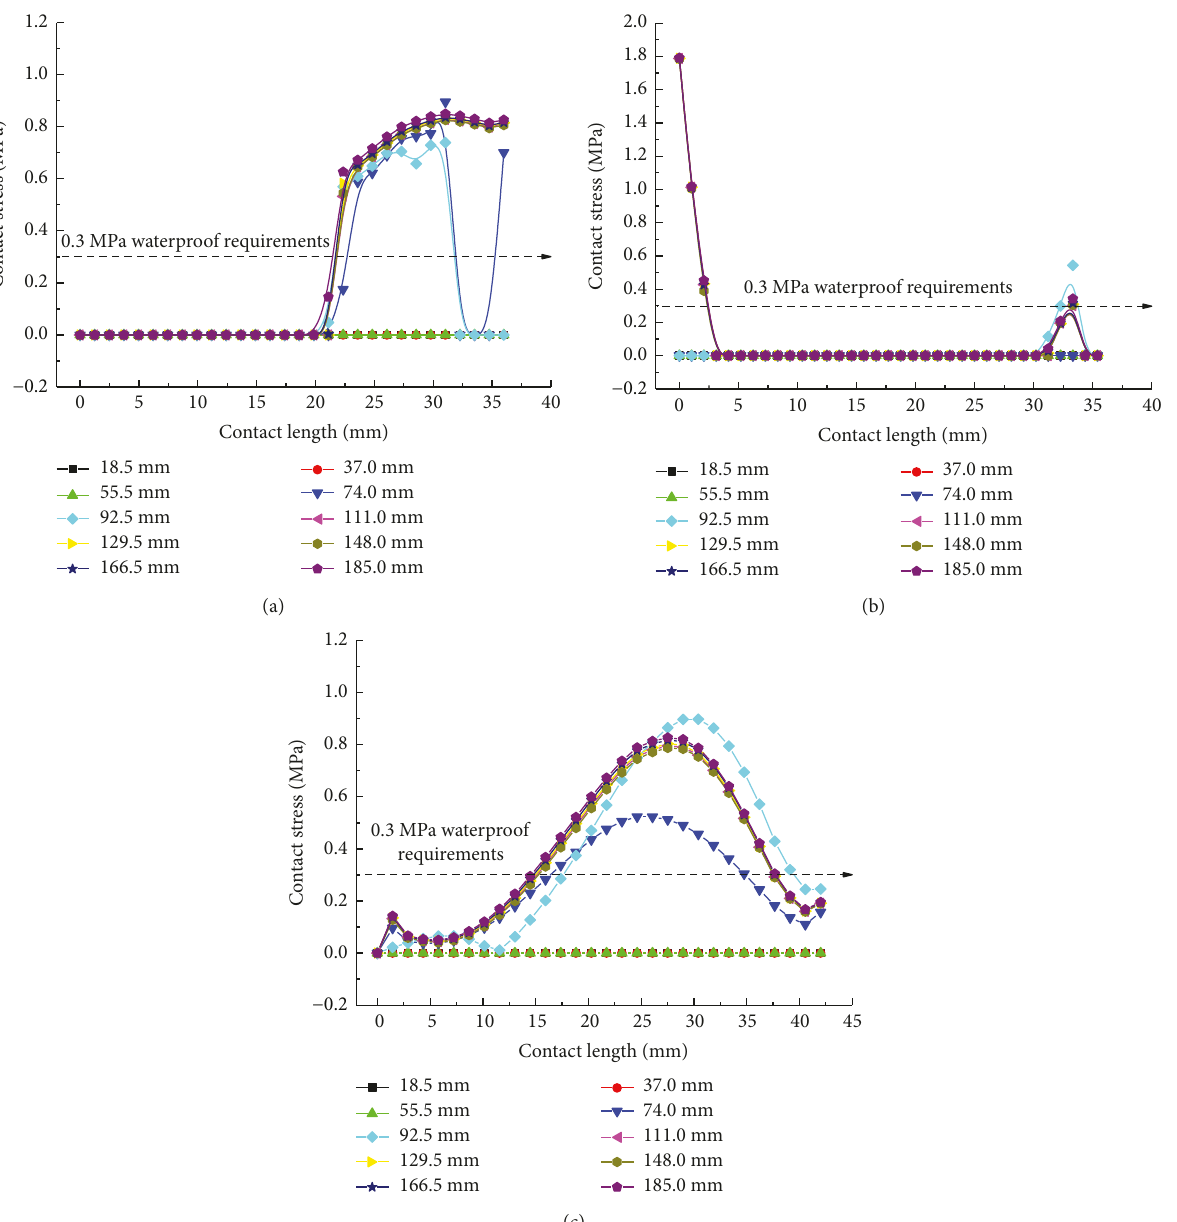
Figure 7: Contact stress curve of the first rubber ring before optimizing during translation: (a) contact pressure of line 1 for the first rubber ring, (b) contact pressure of line 2 for the first rubber ring, and (c) contact pressure of line 3 for the first rubber